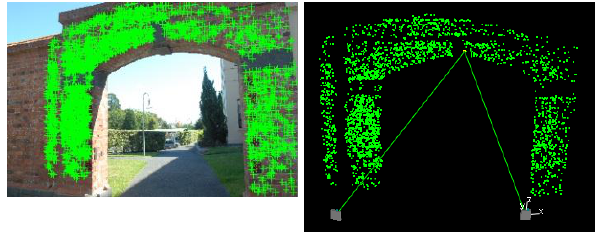
Figure 8. Matching results for a pair of images. The resulting object array contained 2706 points.